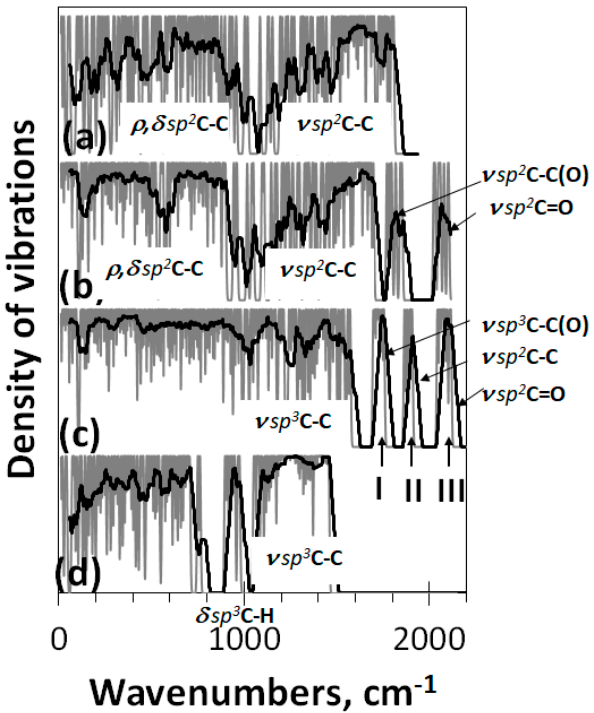
Figure 9. Virtual one-phonon vibration spectra of bare (5,5)NGr domain C 66 ( a ) and its polyderiva- tives: reduced graphene oxide C 66 O 22 ( b ), graphene oxide GO4_17 C 66 O 39 ( c ), and graphene hydride (nanographane [60]) C 66 H 88 ( d ). UHF ( a , b ) and RHF ( c , d ) AM1 UHF calculations.